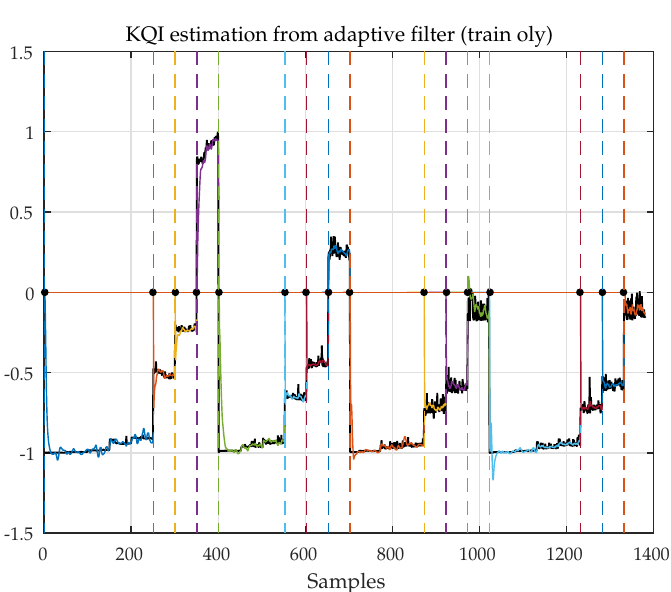
Figure 7. KQI “FTP session total time” as a function of RSSI, RSSQ, RSSP, bandwidth, and file size Figure 7. KQI "FTP Session Total Time" as a function of RSSI, RSSQ, RSSP, Bandwidth and File (colored by segment). Black: original data. Result obtained using the LMS based multivariate FIR Size (colored by segment). Black: original data. Result obtained using LMS-based multivariate FIR adaptive adaptive filter.